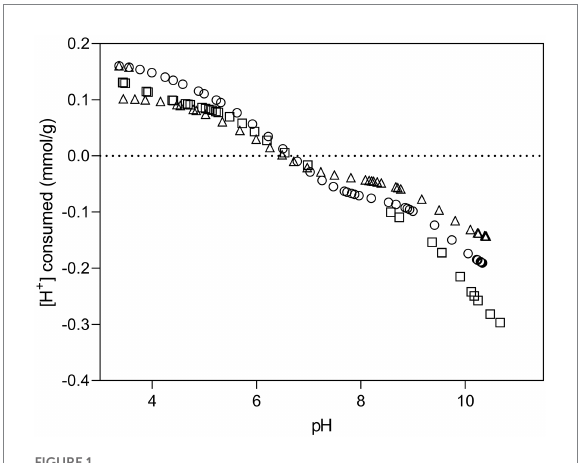
FIGURE 1 Potentiometric titration curves of Be9 strain in of 0.1 M NaClO 4 at 25 ° C. The symbols refer to experimental replicates of each titration